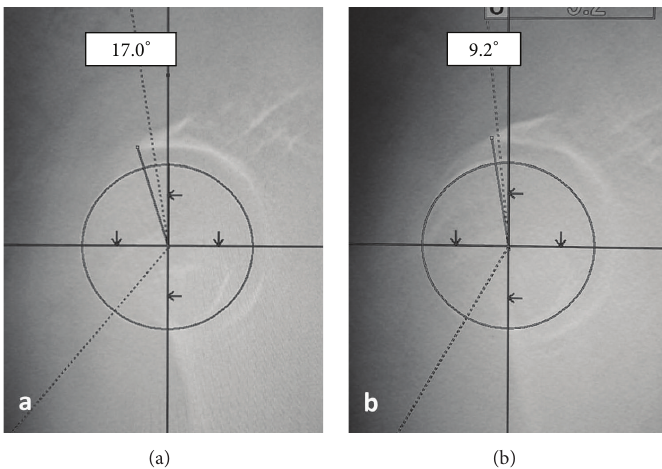
Figure 4: Tomosynthesis of the right hip joint in the sagittal plane in a standing position. (a) The VCA angle is 17.0 ∘ in a natural standing position. (b) The VCA angle is 9.2 ∘ while standing on tiptoes with hip extension.